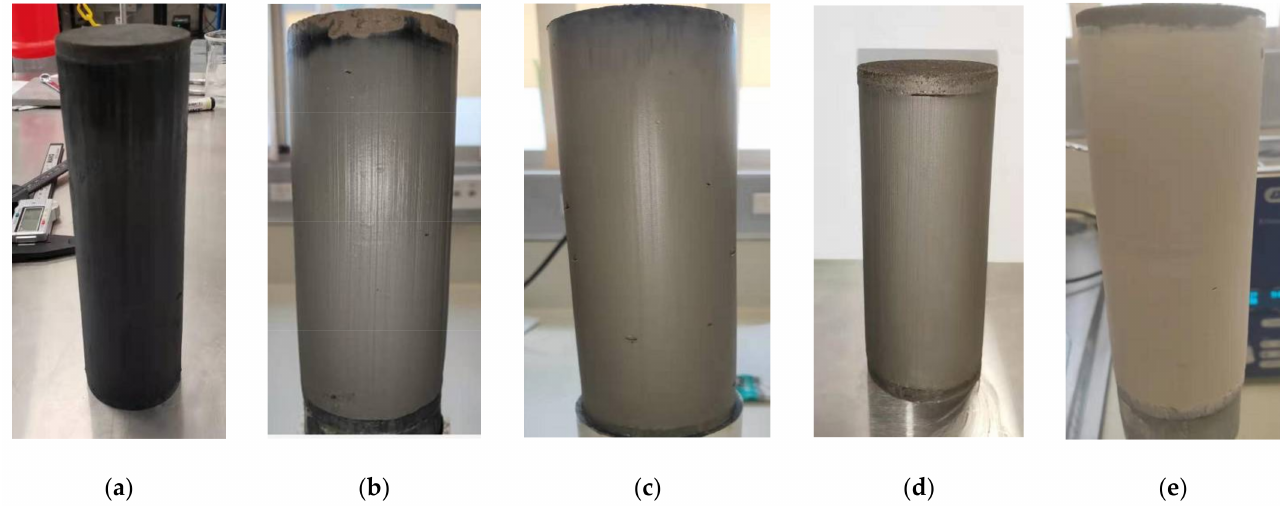
Figure 2. Some soft soil specimens for consolidated undrained triaxial testing: ( a ) S1—100% PoB soft soil; ( b )S2—75% PoB soft soil + 25% kaolin soil; ( c ) S3—50% PoB soft soil + 50% kaolin soil; ( d ) S4—25% PoB soft soil + 75% kaolin soil; and ( e ) S5—100% kaolin